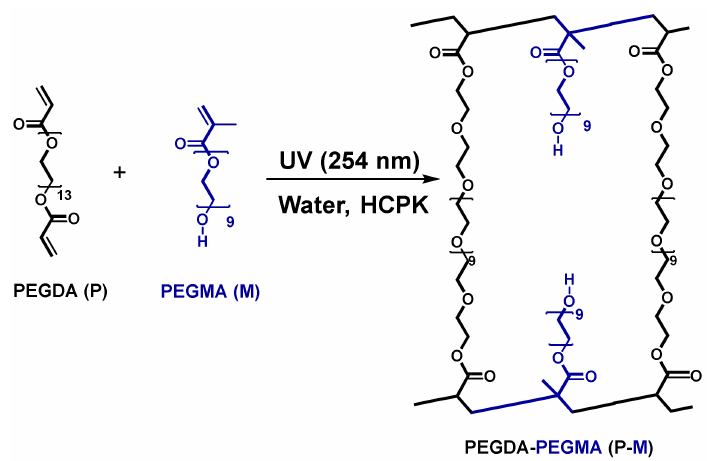
Figure 1. Synthesis of PEGDA-PEGMA